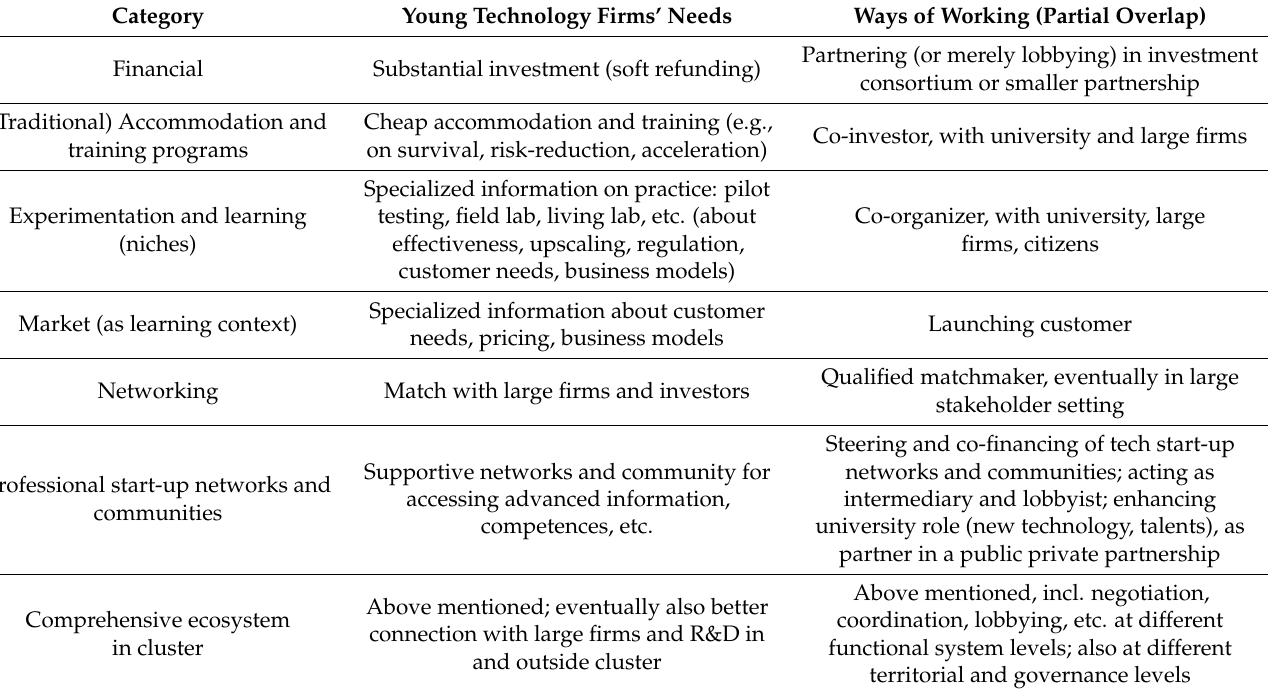
Table 3. Municipalities’ Initiatives and Ways of Working in Supporting Young Technology